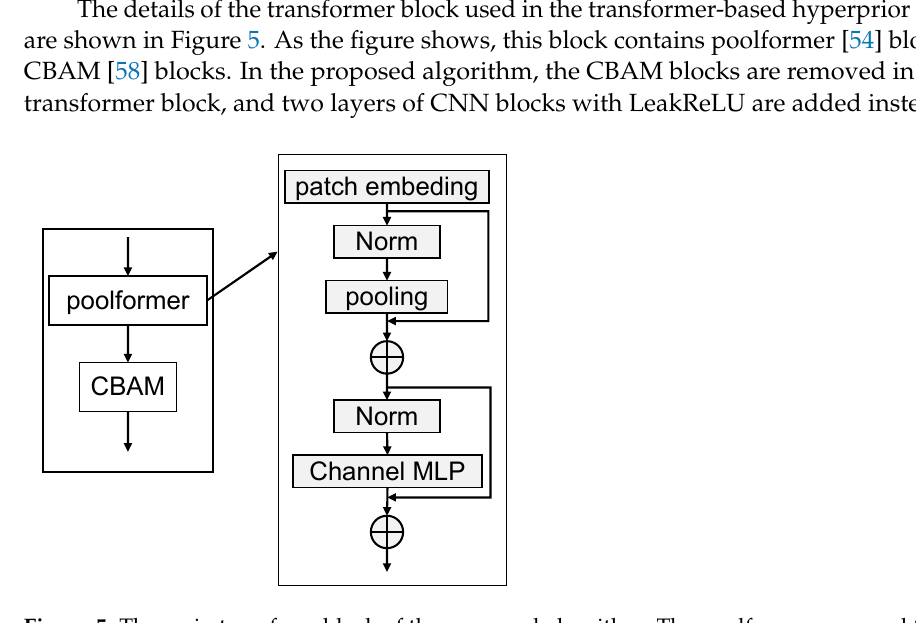
Figure 5. The main transform block of the proposed algorithm. The poolformer removed the token mixture model and used pool layers instead. To enhance the channel and spatial attention, a CBAM block was adopted after the poolformer blocks.